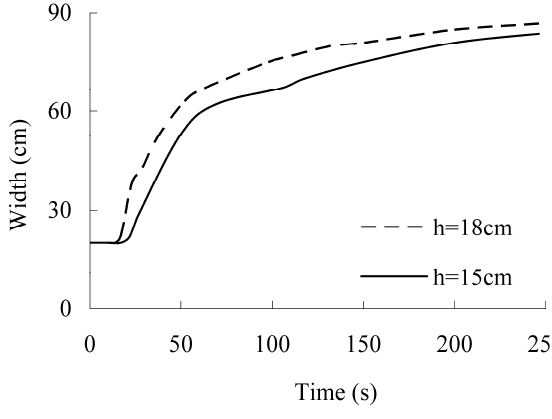
Fig. 13 Relationship between breach width and water-head. Fig. 13. Relationship between breach width and water